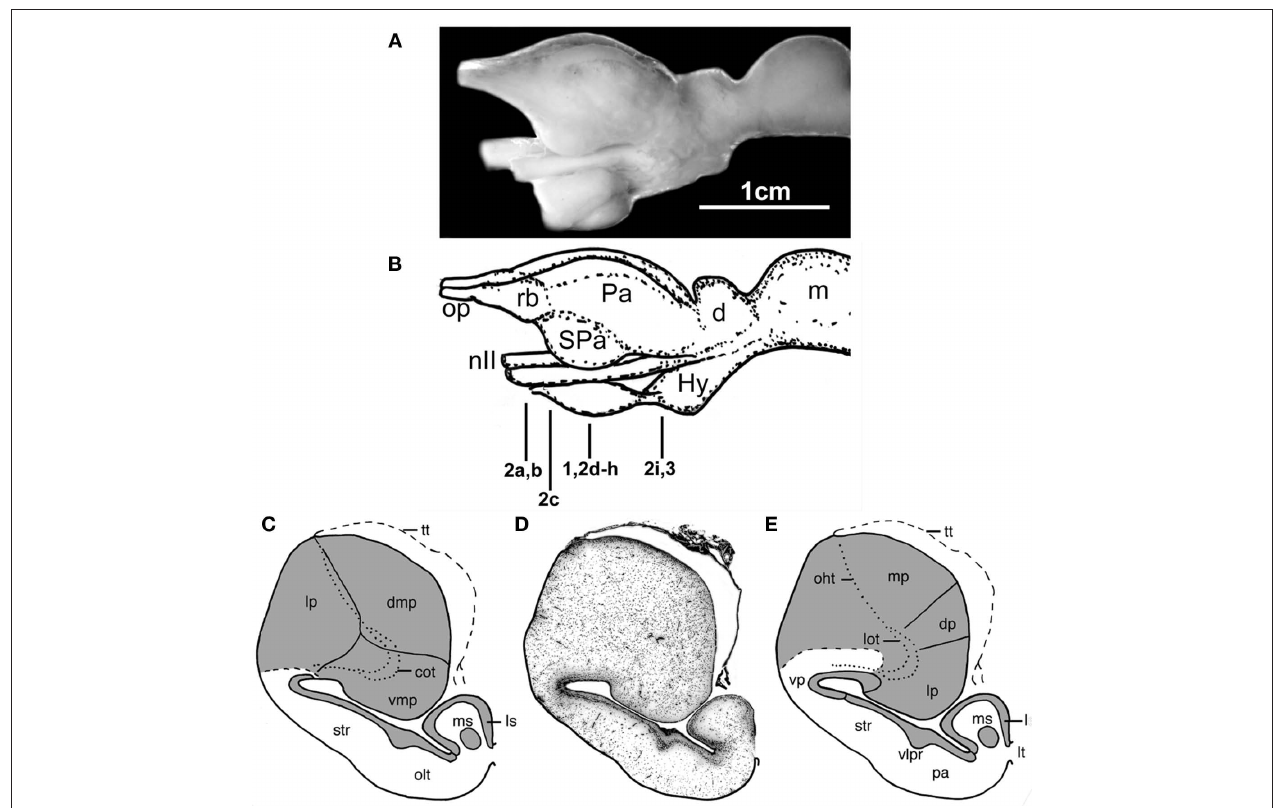
indicate the subpallial–pallial boundary (C) or the boundary between the neuropil of the ventral pallium and the medial pallium (e) . cot, Central olfactory tract; d, diencephalon; dmp, dorsomedial pallium; dp, dorsal pallium; Hy, hypothalamus; Hyp, hypophysis; lot, lateral olfactory tract; lp, lateral pallium; ls, lateral septum; lt, lamina terminalis; m, mesencephalon; mp, medial pallium; ms, medial septum; nII, optic nerve; oht, olfactohabenular tract; olt, olfactory tubercle; op, olfactory peduncle, Pa (in lateral view), pallium; pa (in transverse section), pallidum; rb, rostral body; SPa, subpallium; str, striatum; tt, telencephalic tela; vlpr, ventrolateral cellular prominence; vmp, ventromedial pallium; vp, ventral